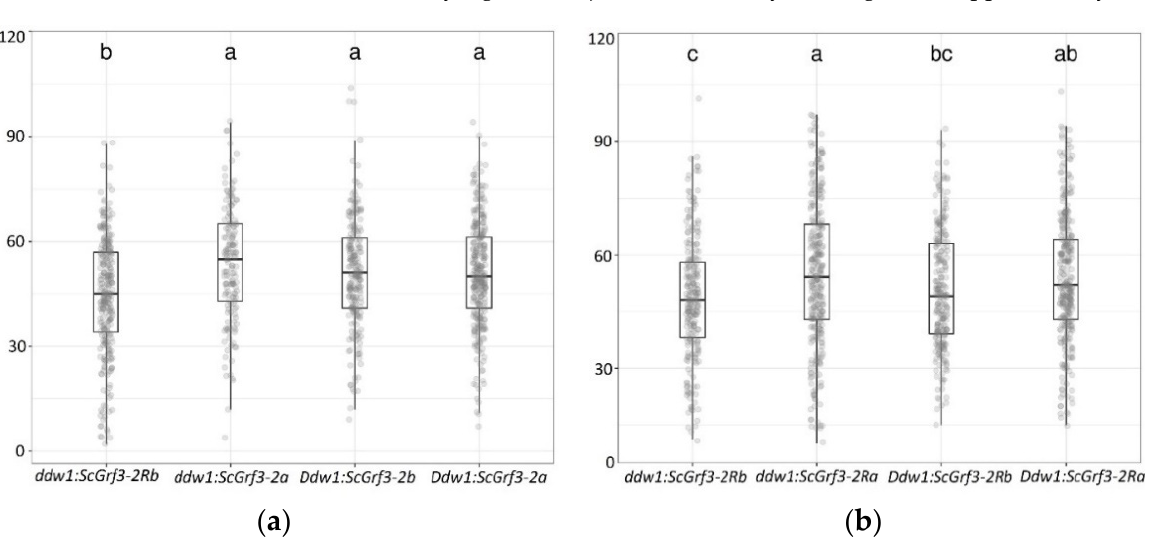
Figure 3. Grain number per main spike (pieces) in recombinant triticale lines with different combinations of Ddw1 and ScGrf3-2R alleles in 2018 ( a ) and 2019 ( b ). Letters denote significantly different groups at a significance level of 0.05 according to Tukey’s test. The rectangles show the interval between the 1st and 3rd quartiles, the vertical lines show the maximum and minimum values, the horizontal line inside the rectangle indicates the median, dots show the trait values of individual